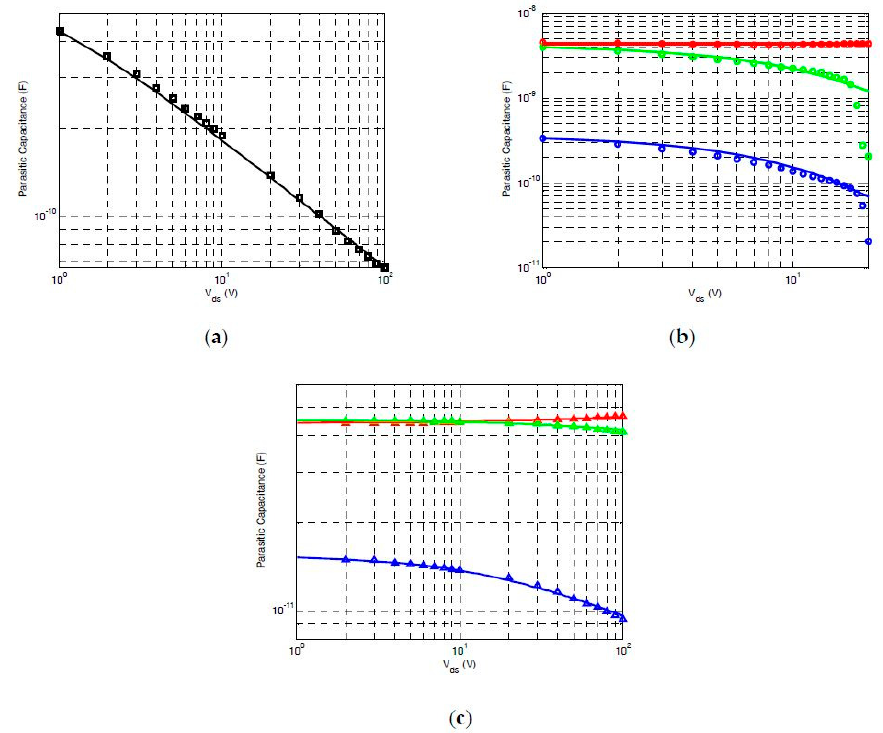
Figure 5. Log–log plot of the ( a ) parasitic capacitance for the silicon carbide (SiC) Schottky barrier diode (SBD) versus the drain–source voltage (square: measured, solid line: simulation); ( b ) parasitic capacitance for the low-voltage (LV) MOSFET versus the drain–source voltage (circle: measured, solid line: simulation); and ( c ) parasitic capacitance of the MIS-HEMT versus the drain–source voltage (triangle: measured, solid line: simulation). Table 2. Extracted capacitance parameters of the SiC SBD, LV MOSFET, and MIS-HEMT. SiC SBD LV MOSFET MIS-HEMT Par.